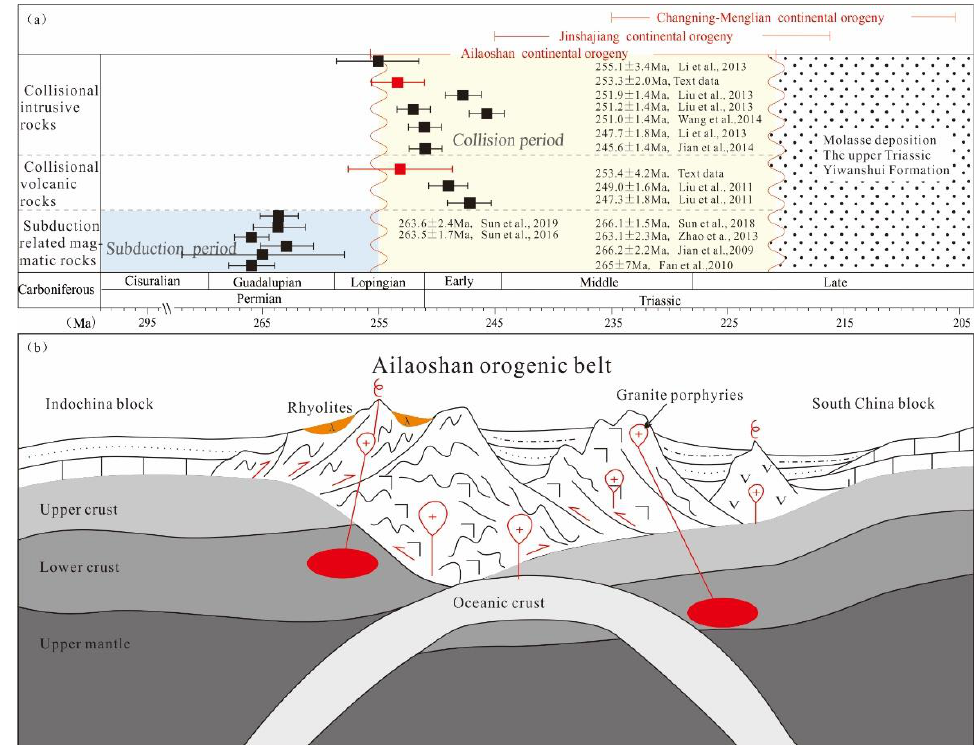
Figure 11. Schematic evolution diagram showing the collision time of the Ailaoshan orogenic belt based on magmatic ages ( a ) (modified by [17]) and a conceptual tectonic model of the Ailaoshan orogenic belt during the late Permian ( b ).